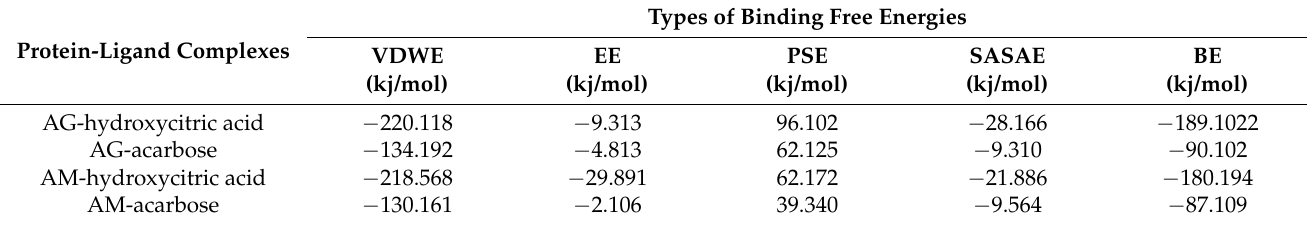
Table 13. Binding free energy values of target proteins complexed with hydroxycitric acid and acarbose. Types of Binding Free Energies Protein-Ligand Complexes AG-hydroxycitric